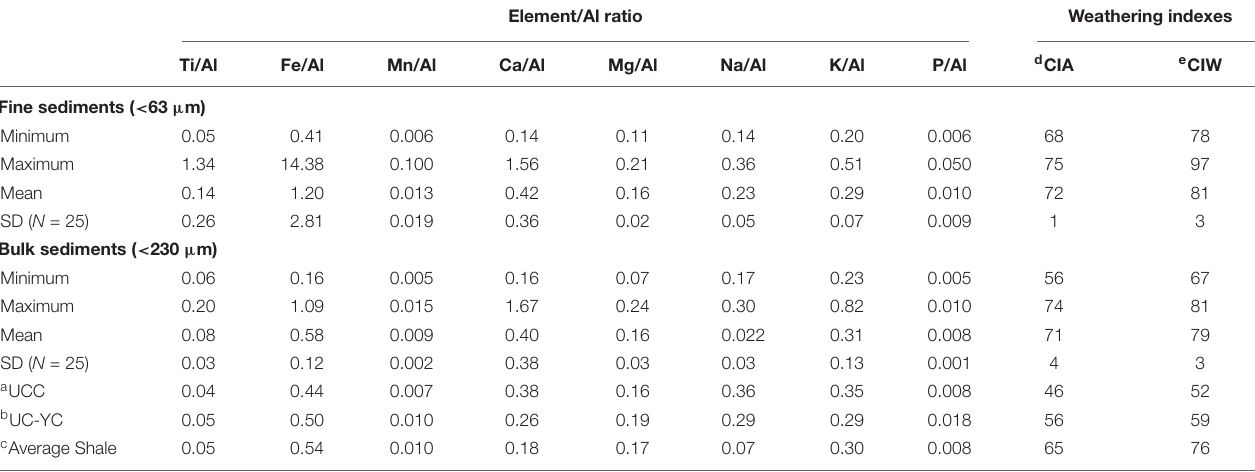
FIGURE 3 | Transect-wise (A–D) mean ( ± SD) concentrations of major elements in bulk ( < 230 µ m) and fine ( < 63 µ m) sediments investigated from off northwest Hainan Island, the Gulf of Tonkin, showing the spatial variability. Note the odd trend of samples from transect D due to the riverine influence with heavy mineral dominance. TABLE 2 | Summary statistics of major element/Al ratios in surface sediments along the west coast of Hainan Island, the Gulf of Tonkin, and their weathering indexes (CIA and CIW) compared with reference compositions. Element/Al ratio Weathering